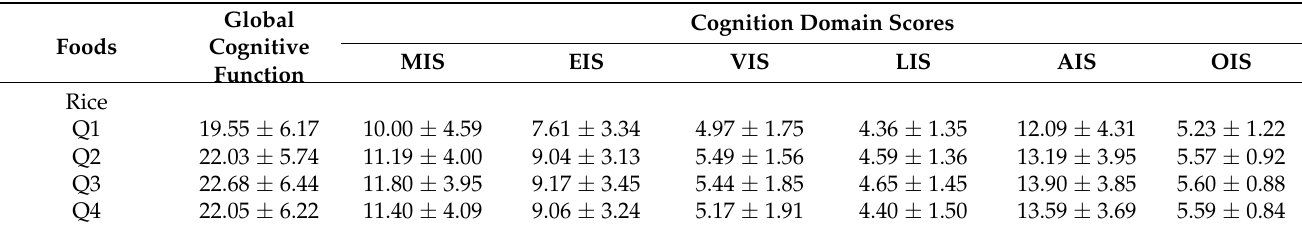
Table 4. Global cognitive function score and cognitive domain subscores of participants according to consumption levels of food subgroups a